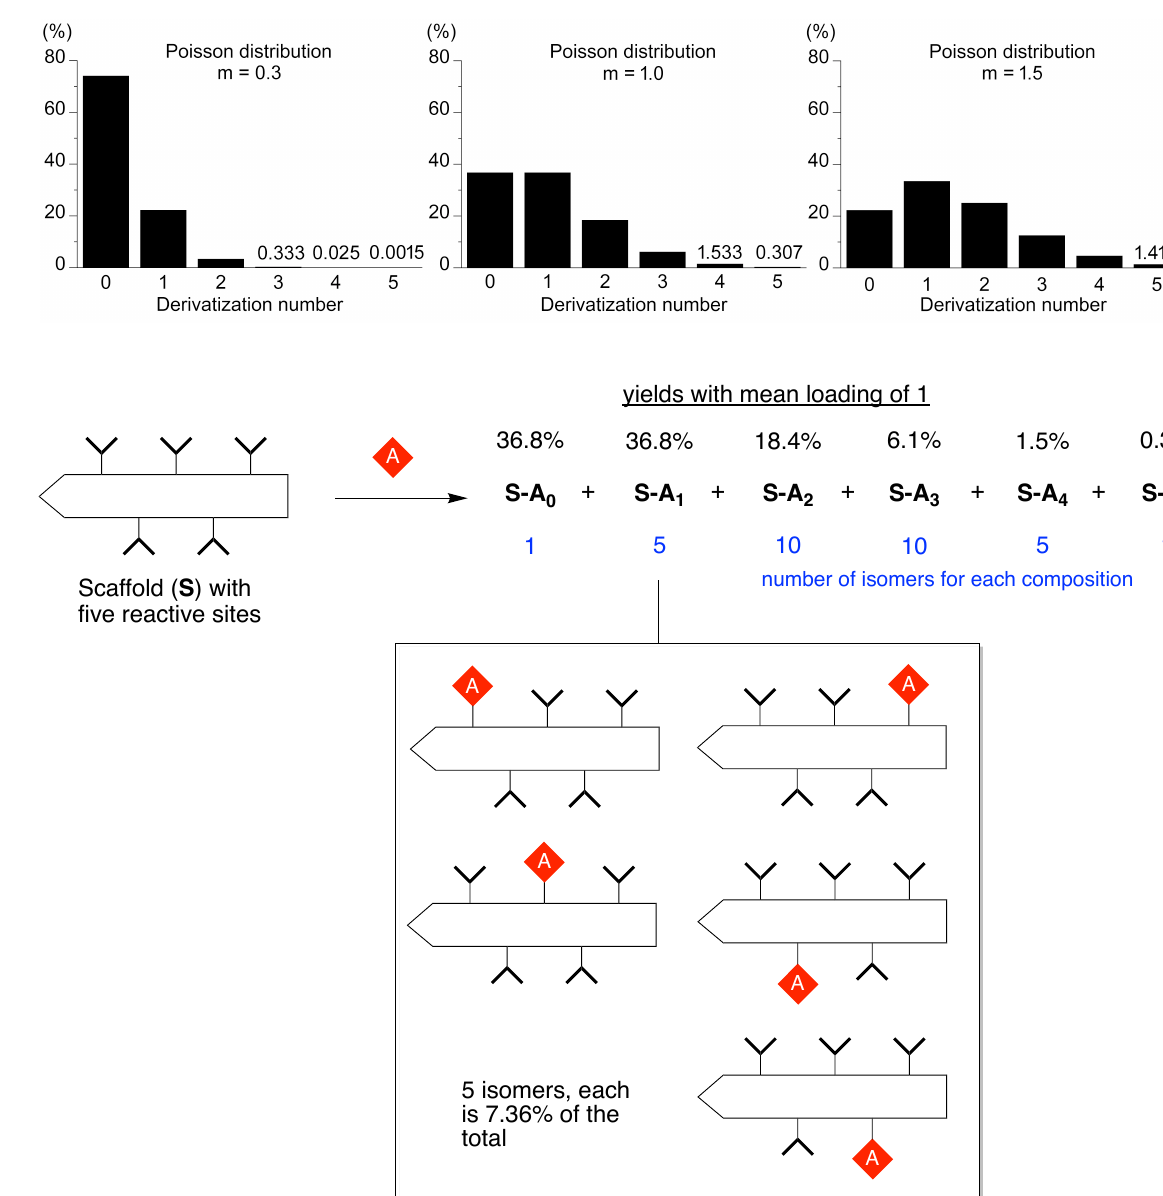
Figure 1. Poisson distribution for m = 0.3, 1.0 and 1.5 ( top panel ). Scaffold S (equipped with five equal and independent reaction sites) undergoes derivatization here with mean loading of one to give a mixture of 32 species ( bottom panel ).